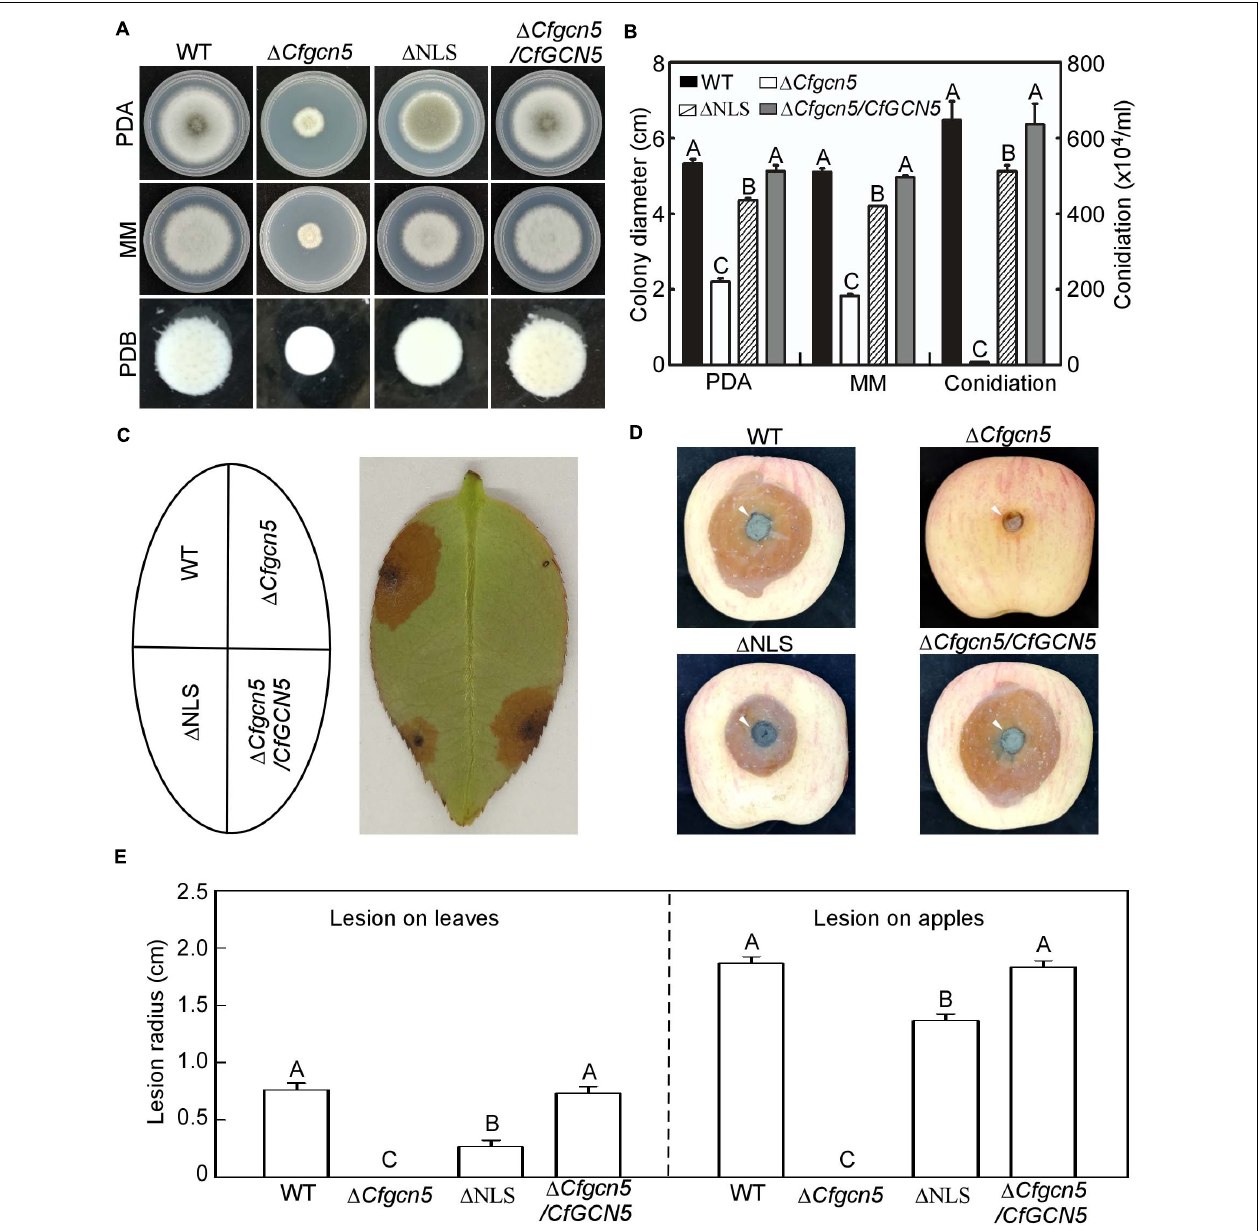
FIGURE 10 | The NLS region is important for the function of CfGcn5. (A) Growth of WT, (cid:49) Cfgcn5 , (cid:49) NLS, and (cid:49) Cfgcn5 / CfGCN5 on PDA and MM plates for 4 days or in liquid PDB for 2 days. (B) Colony diameters and conidiation were measured and statistically analyzed by Duncan analysis. Different letters indicate significant difference ( P < 0.01). (C) Diseased symptoms of wounded tea-oil tree leaves inoculated with related mycelial plugs at 4 dpi. (D) Diseased symptoms of wounded apples inoculated with related mycelial plugs at 5 dpi. Arrows indicate the infection area. (E) Statistical analysis of lesion radius on tea-oil tree leaves and apples. Error bars represent SD of three replicates and different letters indicate significant difference ( P <